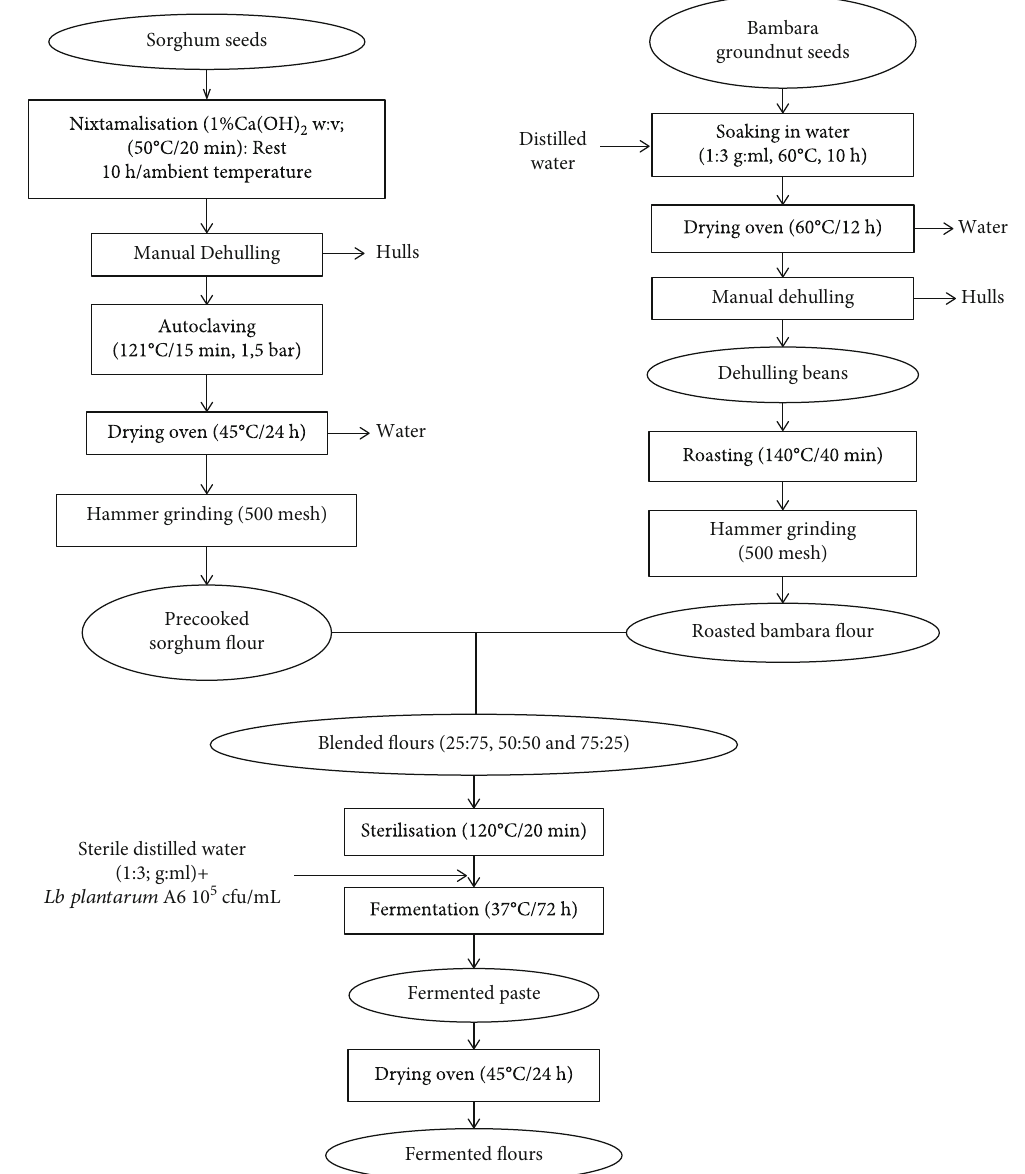
Figure 1: Flow diagram for the production of sorghum and Bambara groundnut precooked and fermented fl